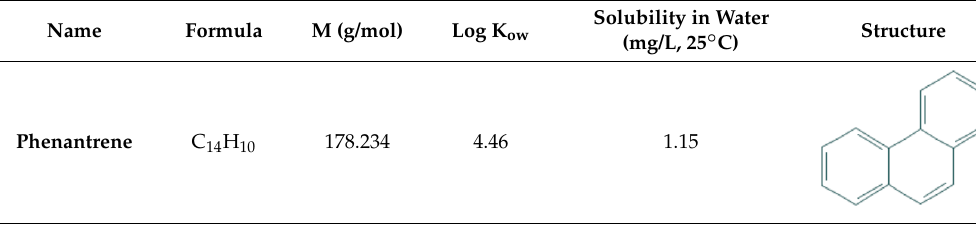
Table 18. Characteristics of Phenantrene (obtained from PubChem).